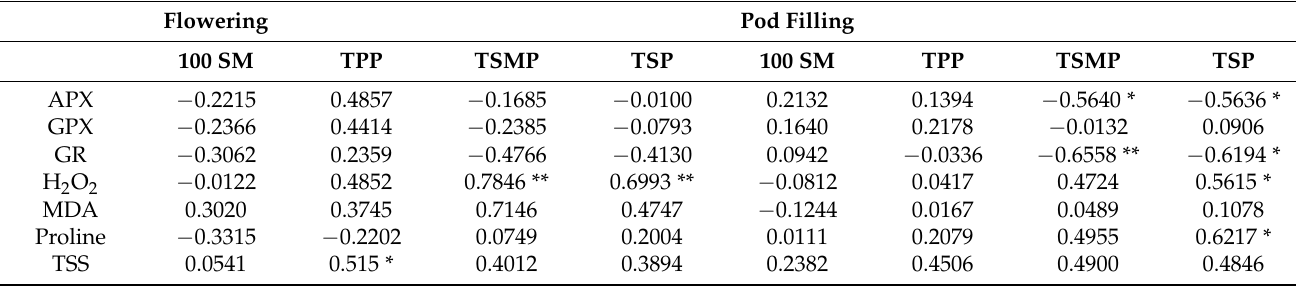
Table 2. Correlations between the biochemical and yield parameters for five vegetable-type soybean cultivars subjected to severe drought stress at flowering and pod-filling